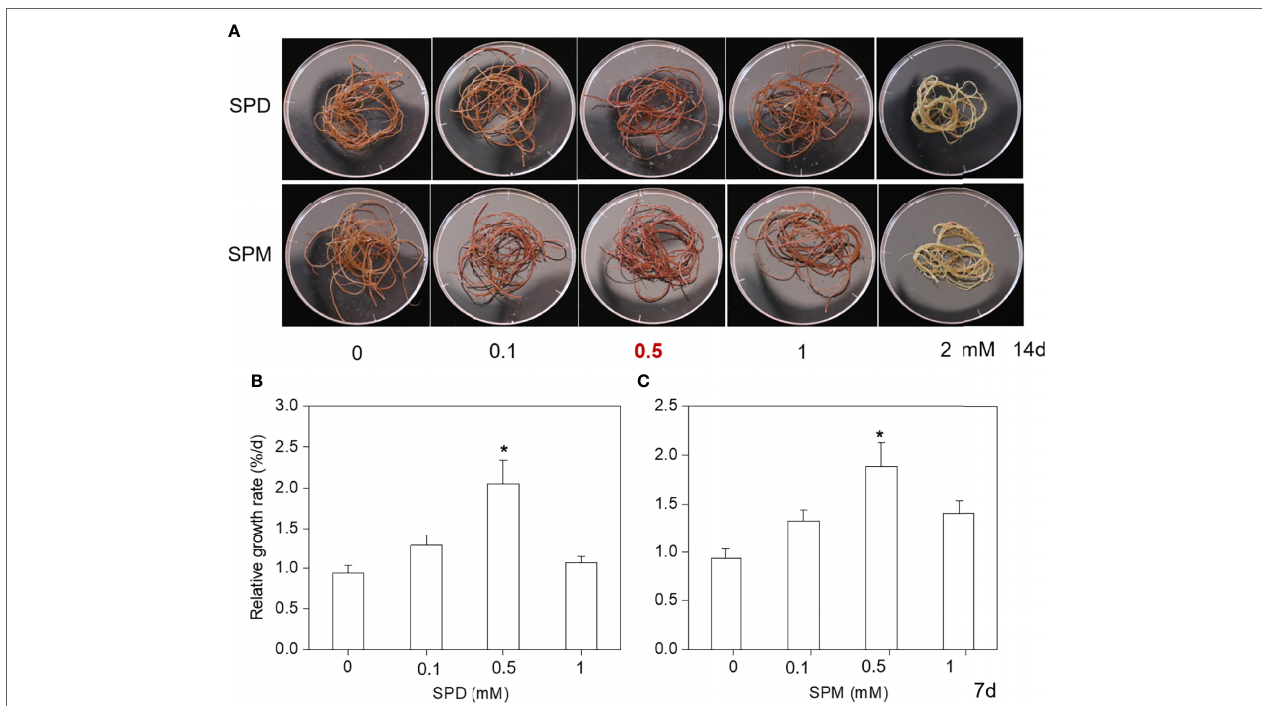
FIGURE 4 | Effect of exogenous PA (SPD and SPM, respectively) at different concentrations on G lemaneiformis under HT stress. (A) Morphological changes of G lemaneiformis during different concentrations (0, 0.1, 0.5, 1, and 2 mM) of SPD and SPM for 14 days high temperature stress treatment. (B) The relative growth rate (RGR) of algae thalli during different concentrations (0, 0.1, 0.5, and 1 mM) of SPD at day 7. (C) The relative growth rate (RGR) of algae thalli during different concentrations (0, 0.1, 0.5, and 1 mM) ofSPM at day 7. Data presented are the means ± standard deviation (SD) from three independent experiments and the asterisk (*) above the columns indicates significant differences at the p < 0.05 level in the algae thalli under HT stress among the different concentrations of PAs treatments and the CK (without PA)